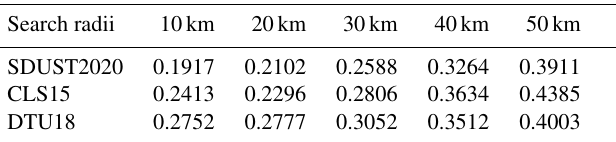
Table 7. SDs of SDUST2020, CLS15, and DTU18 models com- pared with GPS-leveled tide gauges around Japan in different search radii (unit: m).